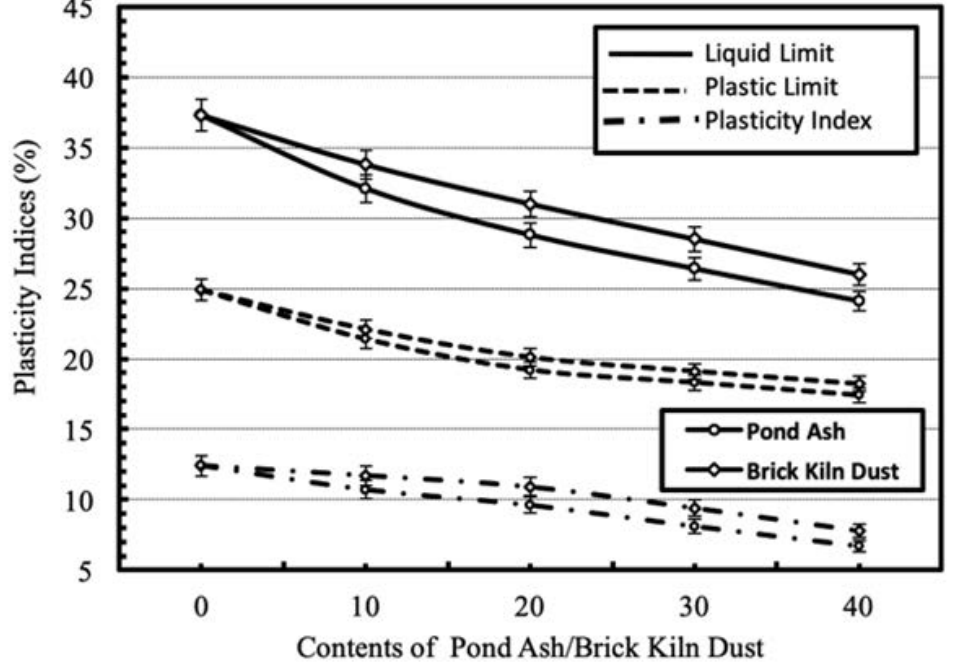
Figure 6. Variation in plasticity indices with varying contents of pond ash or brick kiln